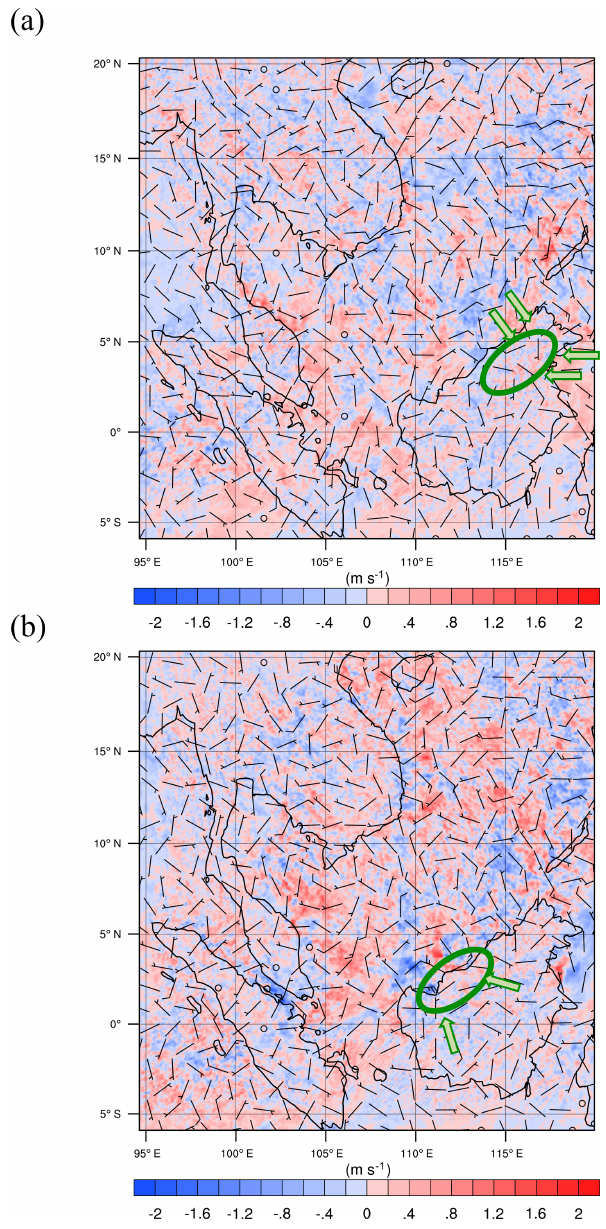
Figure 11. The mean wind field differences of FFBB and FF (FFBB − FF) at (a) 20:00LT for non-nocturnal cases and (b) 02:00LT for nocturnal cases in the Borneo region (r2). The green circle indicates the location in which convections occurred. The green arrows show the mean flow of sea breeze in (a) and land breeze in (b) . The magnitude of wind barbs is 10 times higher than the real